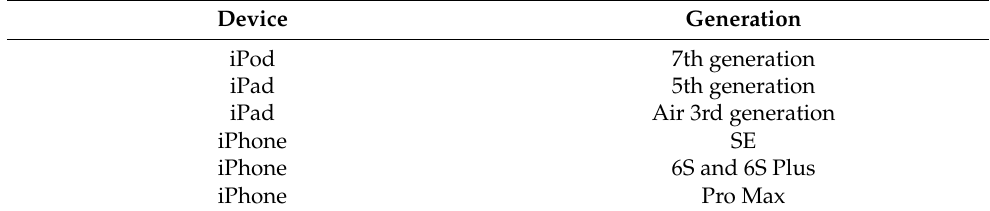
Table 3. Example of supported iOS devices